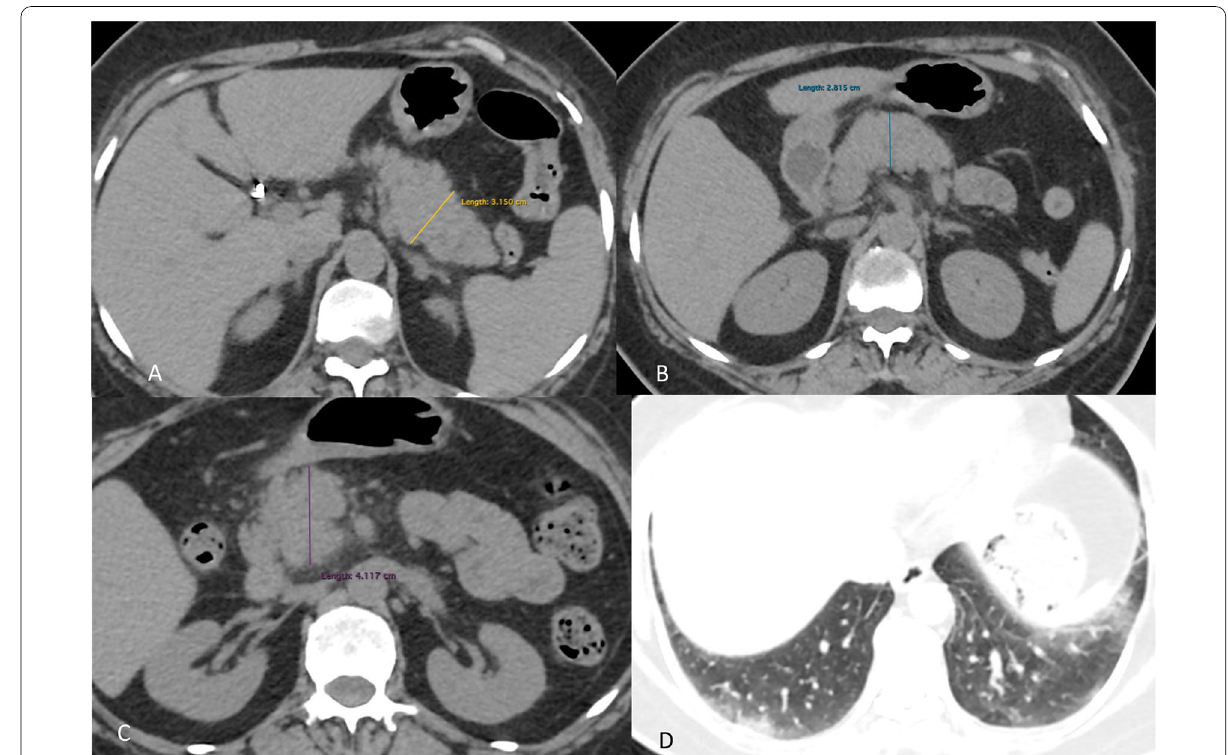
Fig. 4 Non contrast CT images ( A – C ) reveal bulky pancreas with peripancreatic fat stranding. No free fluid is seen. Evidence of post cholecystectomy clips is noted in image A . D Lung window of the same patient shows COVID-19 changes in both lung